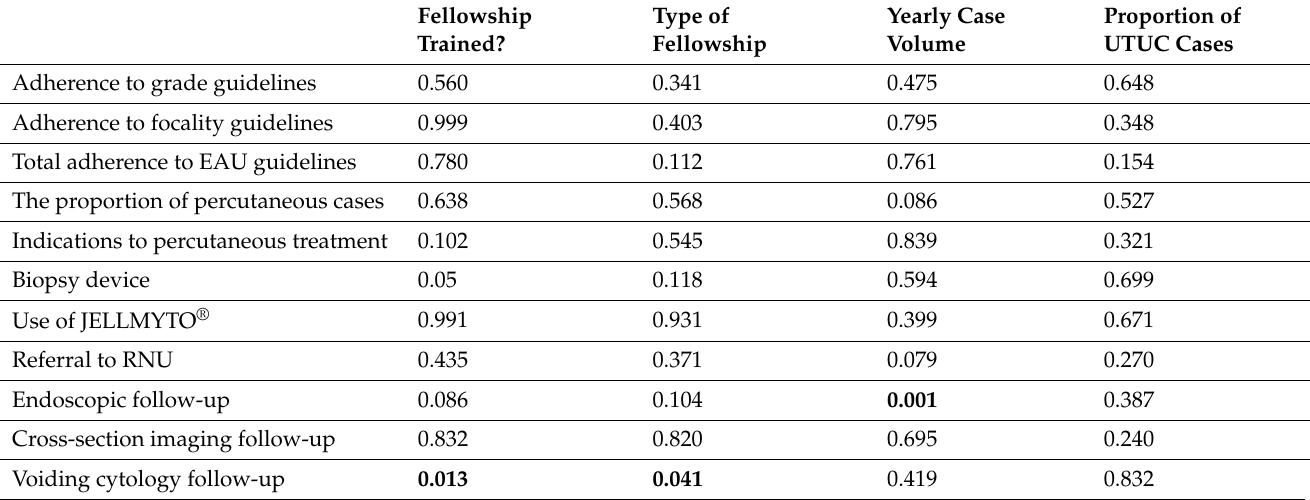
Table 2. Association between surgeon training/experience with management patterns of